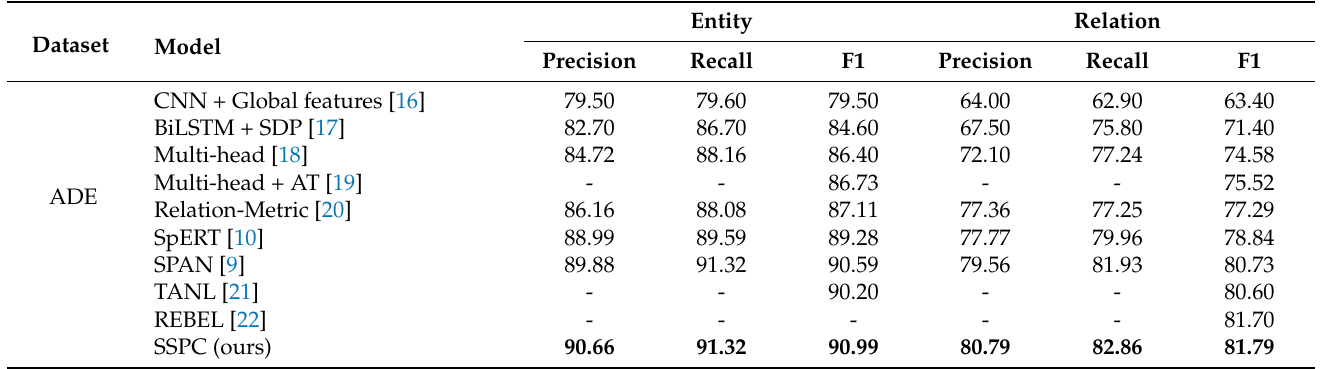
Table 3. Main experimental results on the ADE dataset. The best results are